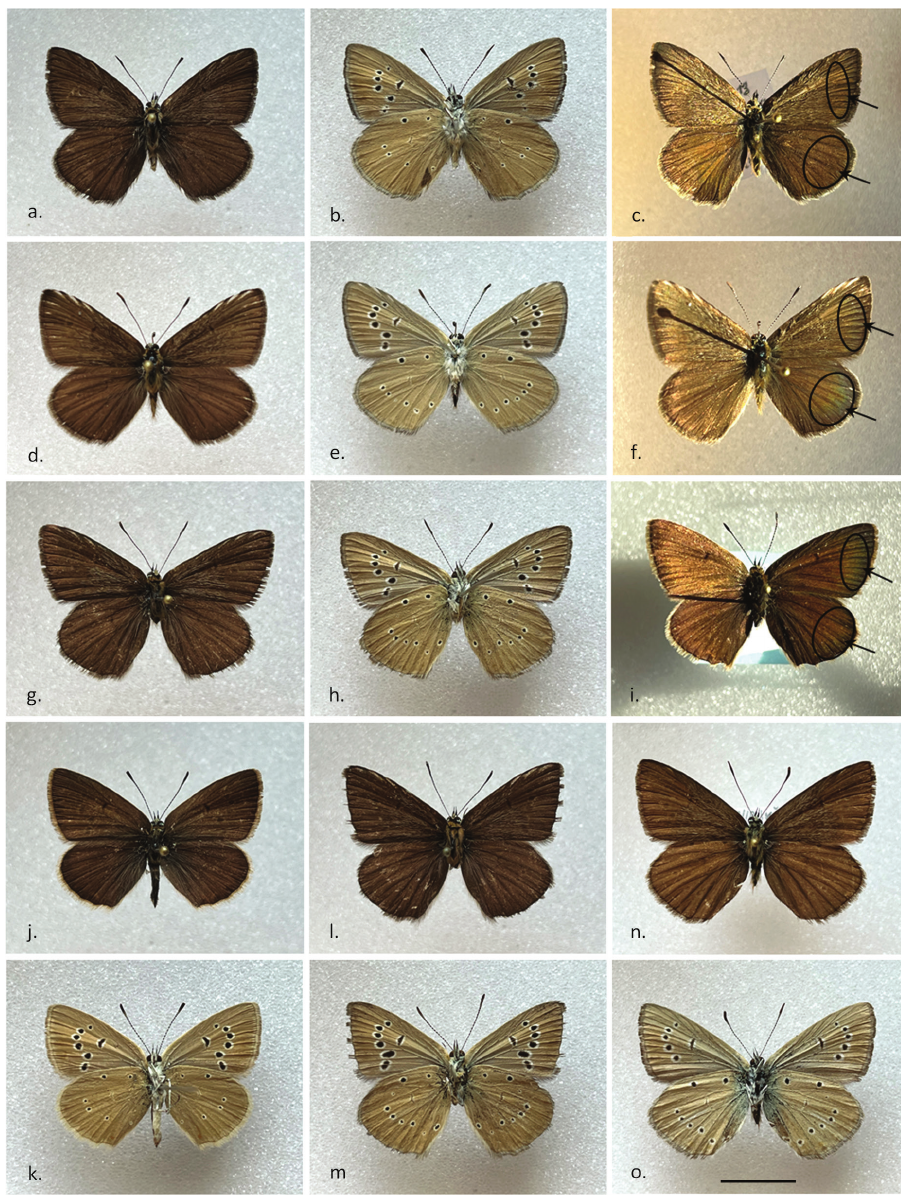
Figure 8. The colouration and wing pattern of P. lurae sp. nov, P. orphicus and P. ripartii . The letters cor- respond to the following species (and voucher sample codes as listed in Table 1): a–c P. lurae sp. nov HT male (18-115-K71) d, f P. lurae × P. orphicus putative hybrid (17-94-3) g, i P. orphicus (18-115-K76) j, k PT female (18-116-K77) l, m P. lurae PT (18-116-X100) n–o P. ripartii (same collecting data as 18-115- K76). Pictures of c, f, i were taken in natural sunlight but with same position as morphometric analysis (see in M&M section); Notice the differences in reflectance on dorsal wings in the postdiscal zone which is circled and indicated by arrow. Scale bar: 10